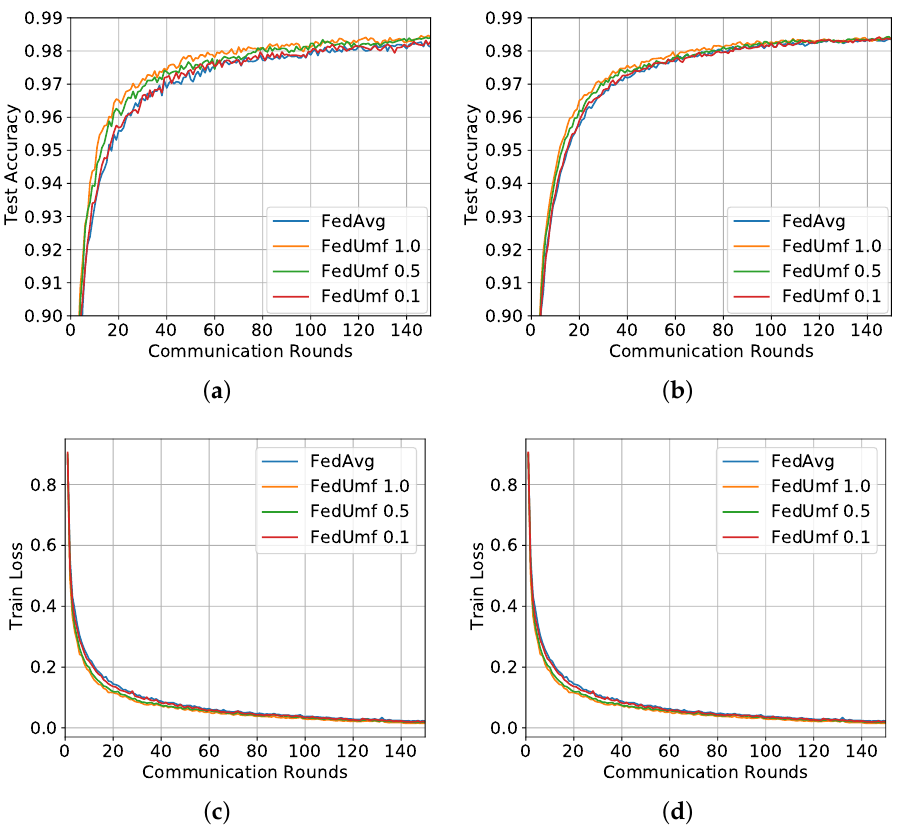
Figure 4. Server test accuracy and client-side training loss curve performance, IID partition and η = 0.05 on MNIST. ( a ) Test accuracy. C = 0.1. ( b ) Test accuracy. C = 0.5. ( c ) Training loss. C = 0.1. ( d ) Training loss. C =